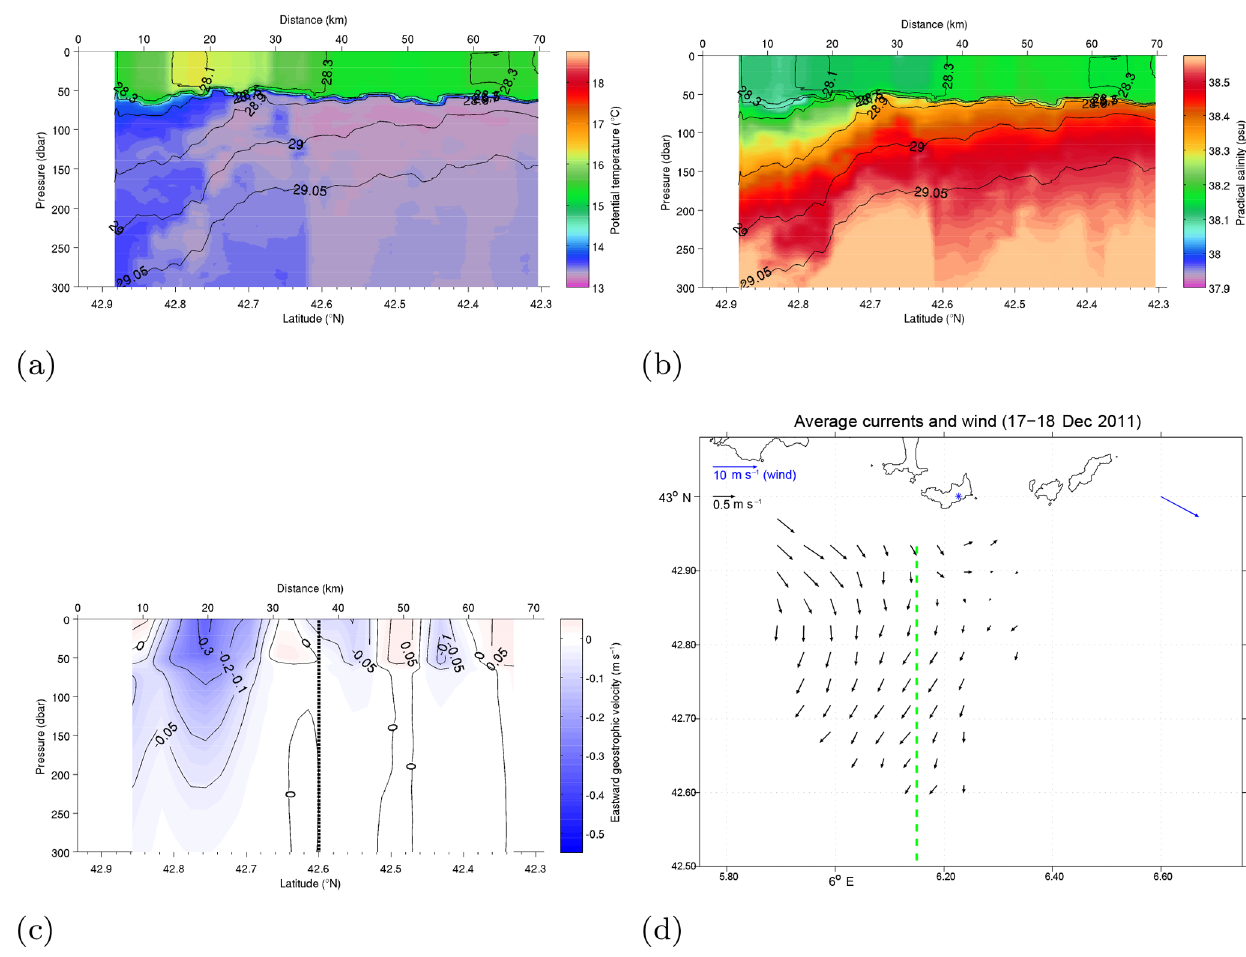
Figure 6. Potential temperature (a) , salinity (b) , and geostrophic velocity (c) for glider Transect 6 (see also Table 1 for time period definition). Potential density anomaly isolines (black) are in panels (a) and (b) . The black dashed line (c) represents the southern boundary of the HF radar field. In panel (d) , black arrows show the surface currents from HFR averaged during the period in which the glider transect (green dashed line) falls inside the HFR coverage (and considering only grid points with at least 80% available data over the time period). The blue arrow represents the wind from Porquerolles station averaged over the same period considered for the HFR